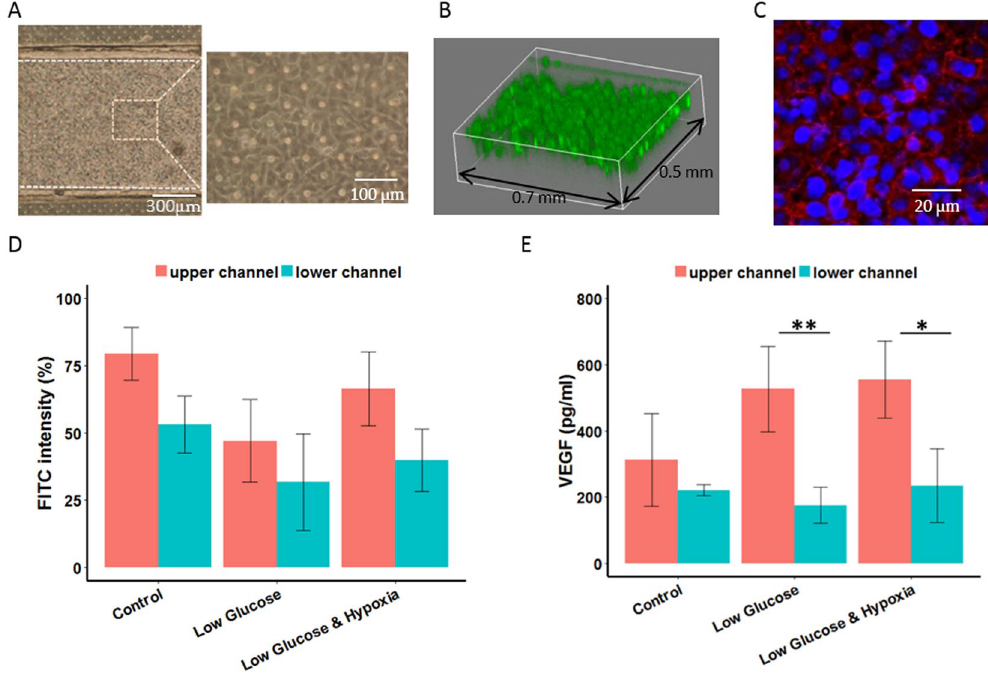
Figure 2. Characterisations of ARPE-19 cells. ( A – C ) Qualitative assessment of the monolayer inside a microfluidic device. ( A ) Optical microscopic image, ( B ) 3D confocal microscopic image (cell tracker green), and ( C ) fluorescent image (blue: nucleus; red: ZO-1). ( D , E ) Plots of permeability to FITC-Dextran and concentrations of VEGF secretion under different conditions imposed by altering glucose concentration and/ or adding CoCl 2 to the medium. Data sets were analyzed using 2-way ANOVA tests (showing a significant interaction effect for ( E ), p = 0.04); the asterisks * indicate significant findings from Tukey’s post-hoc tests. ( D ) mean FITC intensity (%) from lower channels is significantly different than those from upper channels ( * p = 0.0005); pairwise comparisons between conditions are insignificant. ( E ) Pairwise comparisons between experimental conditions are insignificant while pairwise comparisons among the condition (red and blue bars for low glucose and low glucose & hypoxia) are significant ( ** p = 0.0022 and * p = 0.0162, respectively). N = 9 for ( D ) and ( E